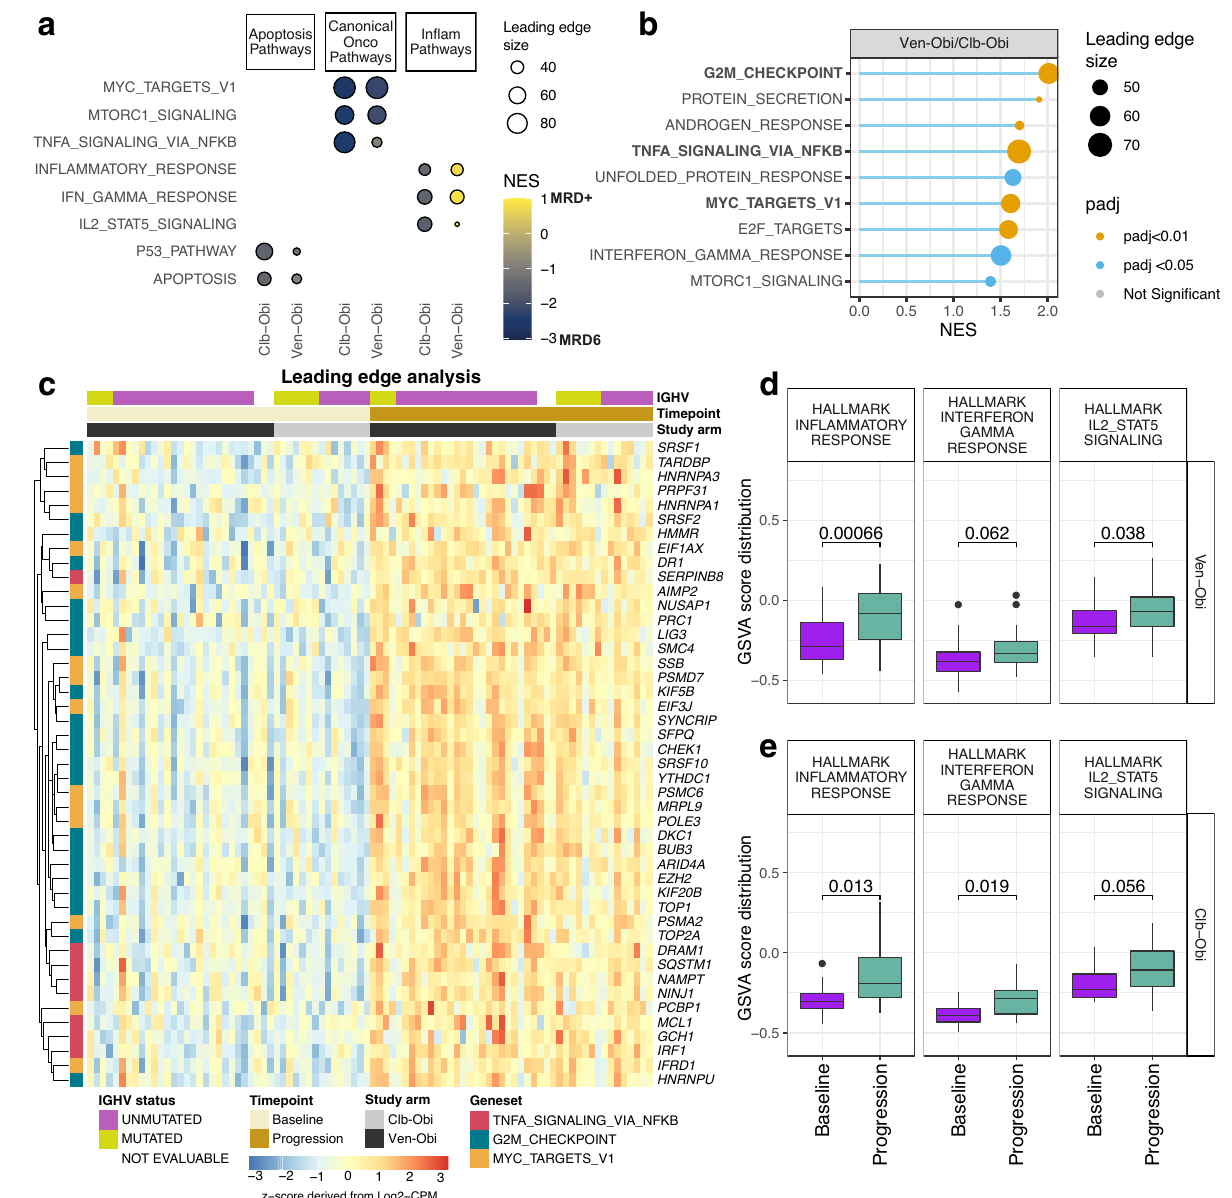
Fig. 4 | Gene set enrichment analyses according to minimal residual disease status and baseline versus relapse status. a Summarized pre-treatment gene set enrichment analysis of hallmark gene sets according to treatment arm and according to EOT MRD6 and MRD+status. Positive normalized enrichment scores (NES) indicates gene sets enriched in MRD+ and negative NES indicates gene sets enriched in MRD6. b Patient-level gene set enrichment analysis of relapse versus baseline samples in both arms. Signi fi cantly enriched hallmark gene sets (adjusted p -value <0.05) are highlighted, positive NES indicate enrichment in relapsed sam- ples. P -values derived from non-parametric permutation test and adjusted for multiple testing using the Benjamini-Hochberg procedure. c Leading edge analysis